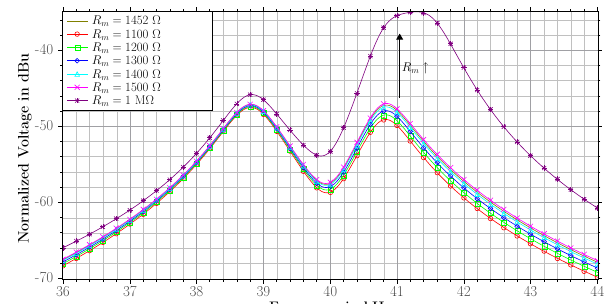
Figure 5. Graph of the voltages over different measurement resis- tor R m values. The curves have different slopes and intersect for a measurement resistance of R m ≈ 1452 (cid:127) .